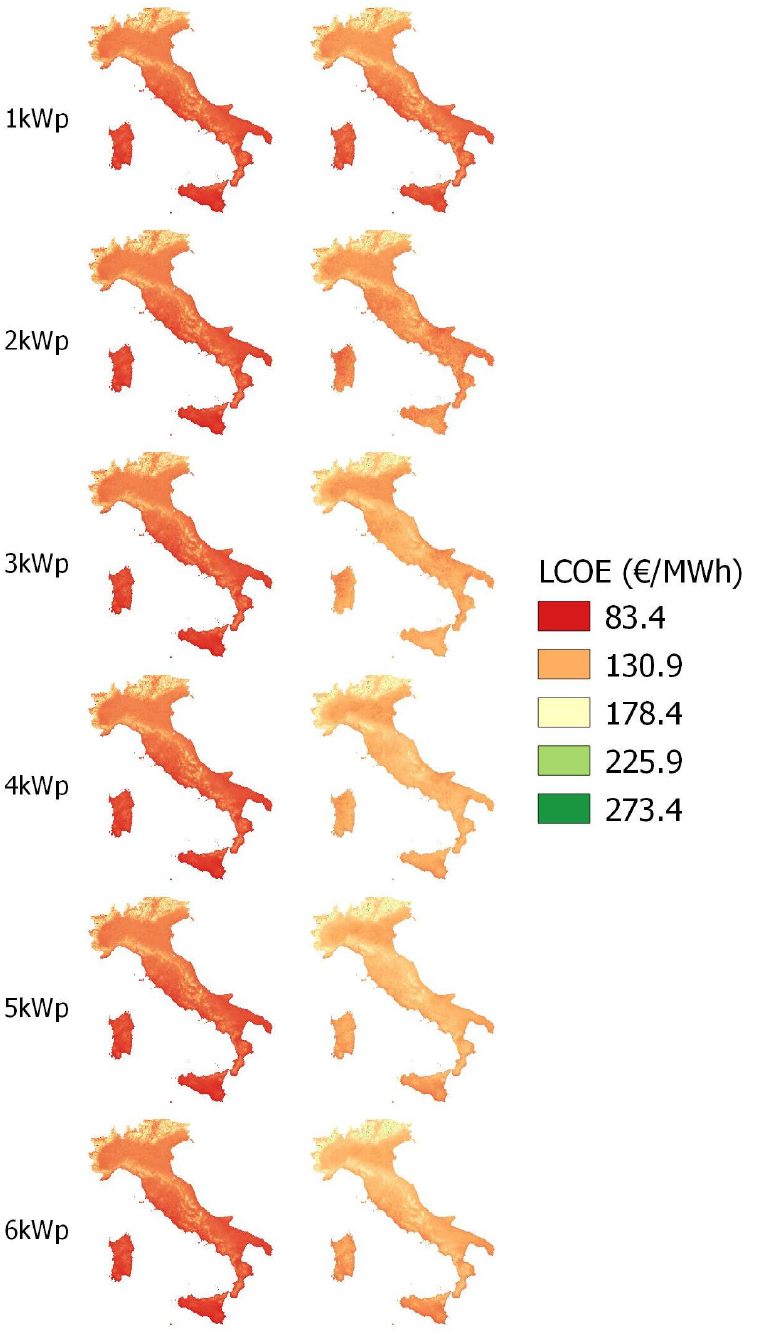
Figure 2. Levelized Cost of Energy (LCOE) of photovoltaic (PV) sintallation, left side without battery and right side with